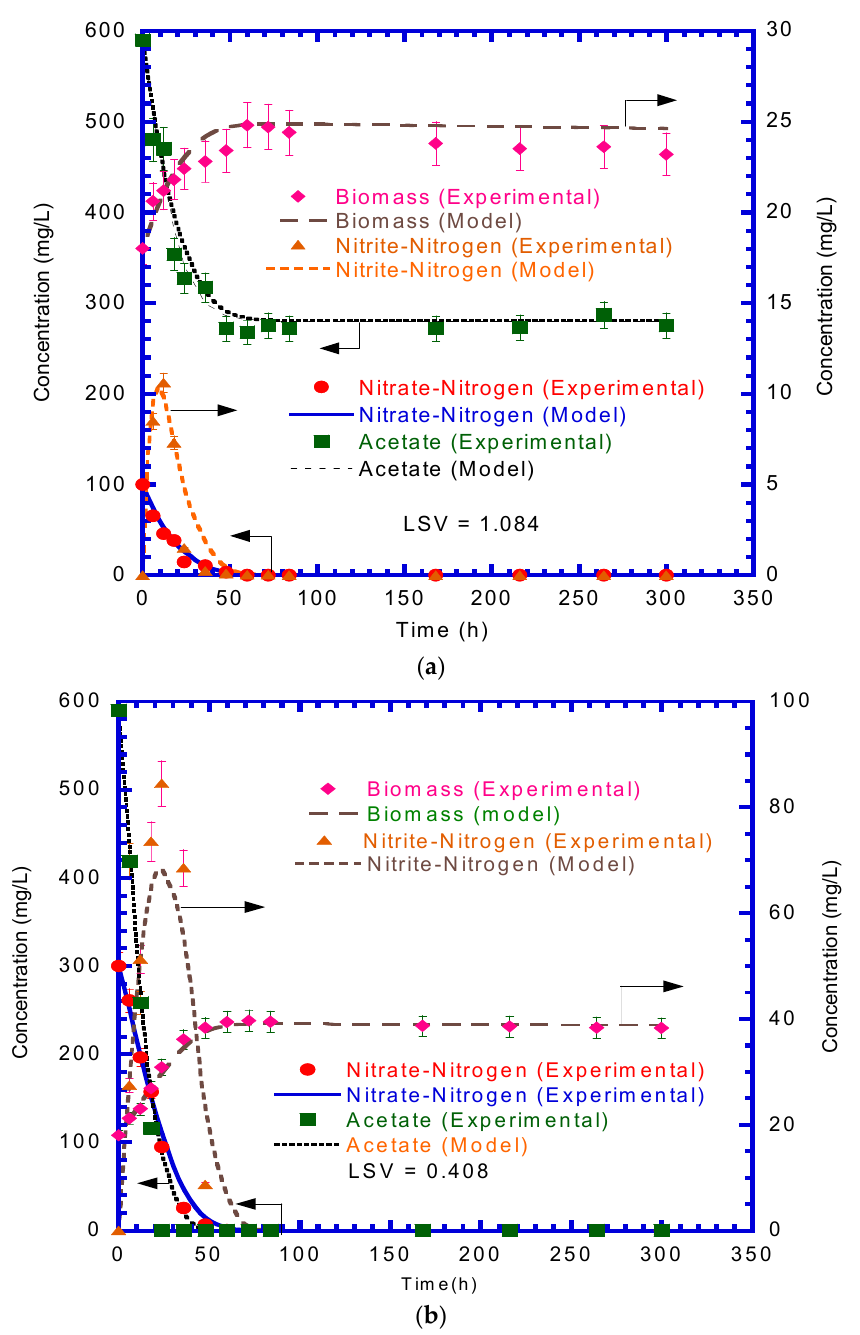
Figure 3. Batch denitrification at initial nitrate-nitrogen concentration of ( a ) 100 mg/L and ( b ) 300 mg/L. Symbols are the average value of the data obtained in duplicate experiments and error bars are the associated standard deviations. Solid and dash lines represent the model prediction.